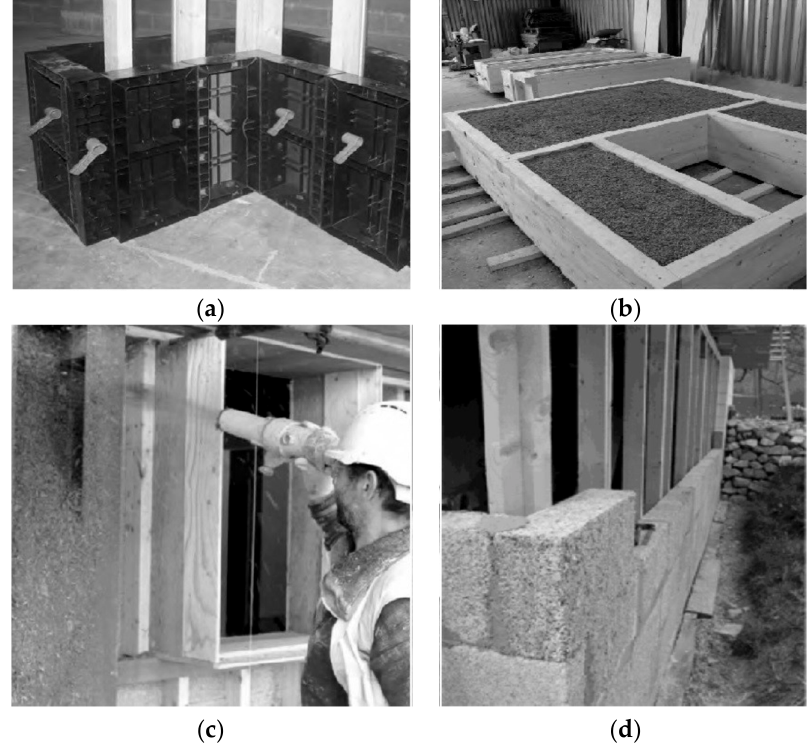
Figure 2. Hemp lime composite techniques: ( a ) casting monolithic walls, ( b ) prefabrication of the entire wall elements, ( c ) spraying, and ( d ) bricklaying [21].